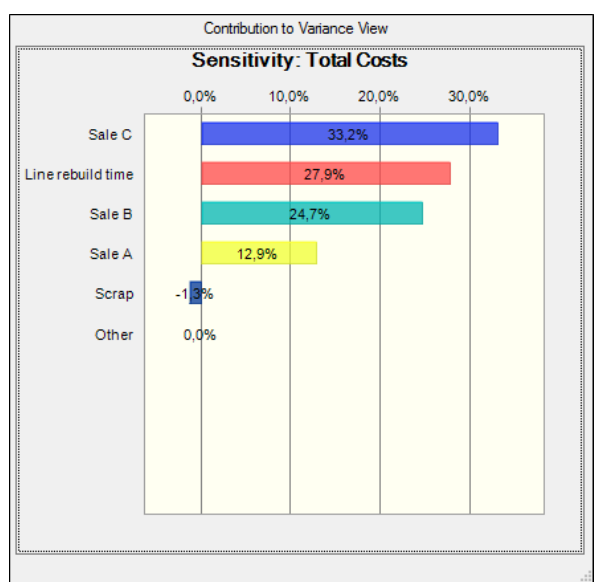
Figure 10: Sensitivity analysis of total costs.